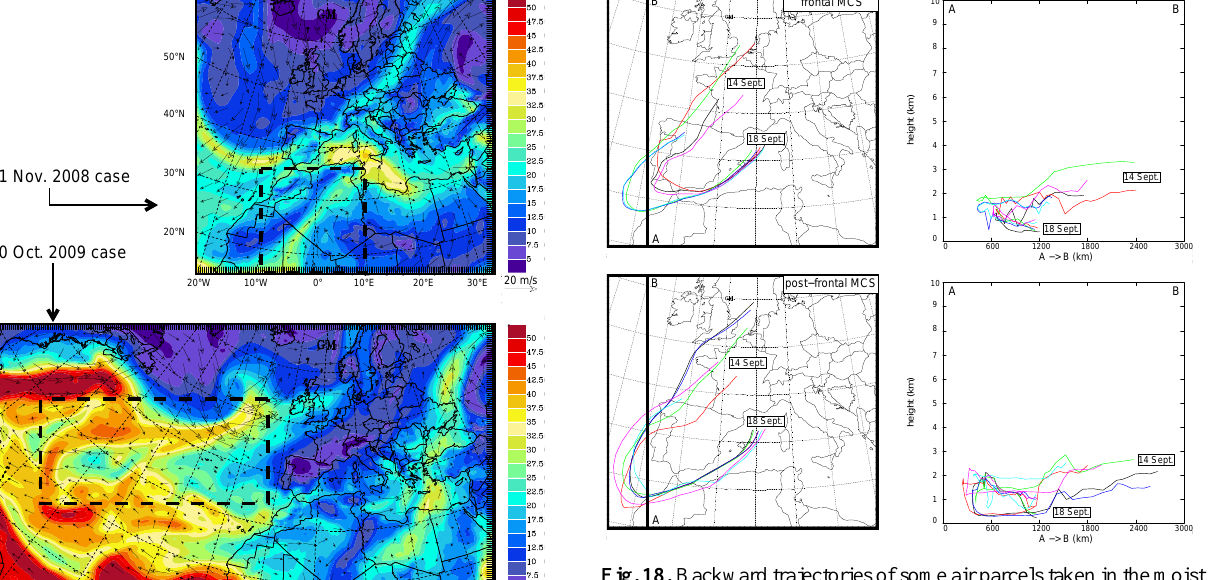
low-level flow feeding the 18 September 2009 precipitating systems withtheRAI10simulationintwodifferentphases oftheevent-convection embedded inafrontaldisturbance (top)andpost-frontalmature